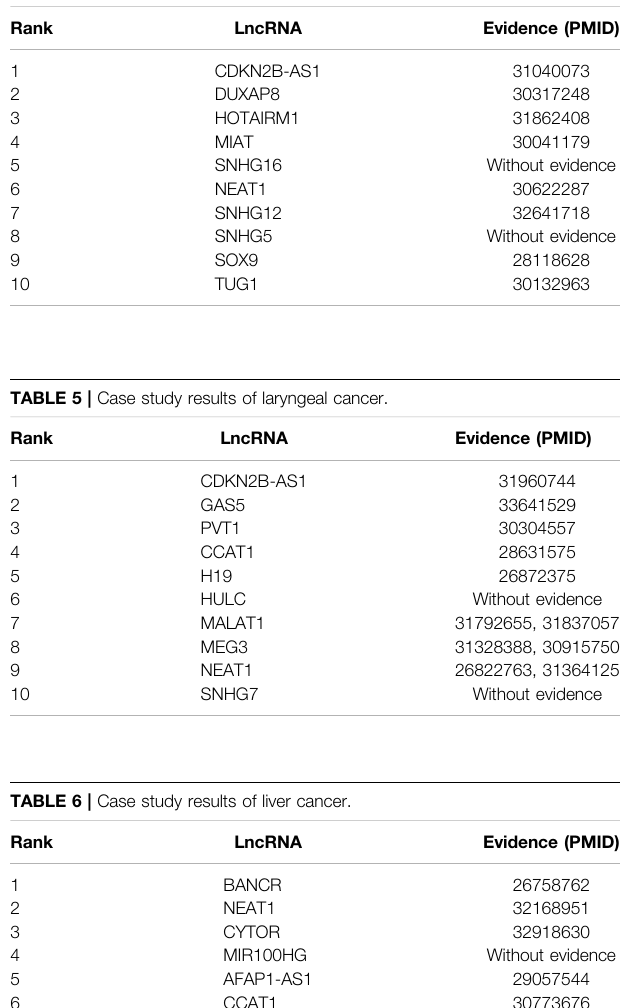
TABLE 4 | Case study results of kidney neoplasms.